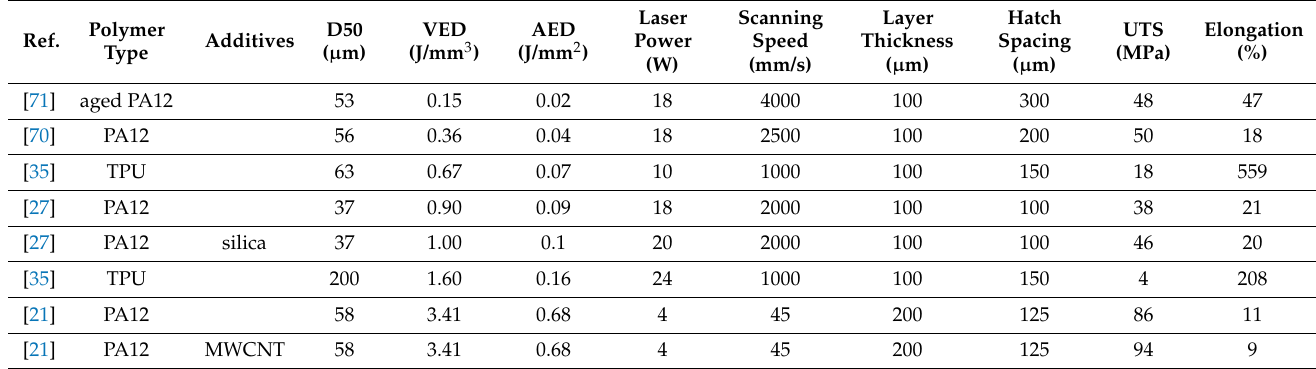
Table 2. Data matrix of the